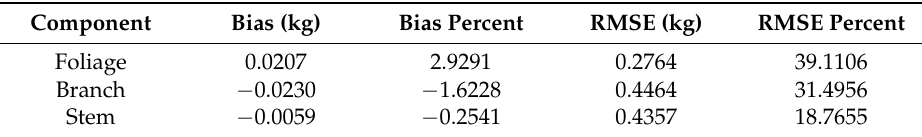
Table 4. Bias and root mean squared error (RMSE) obtained from beta